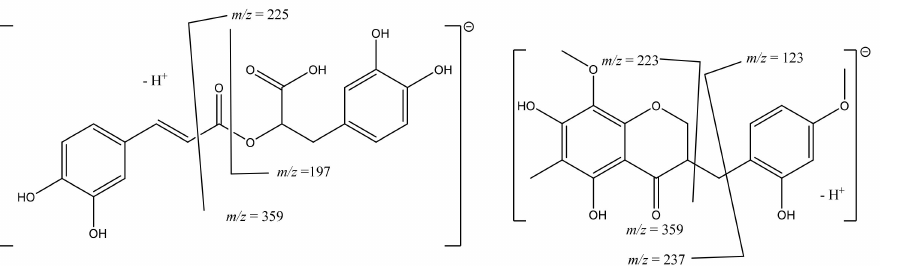
Figure 3. Rosmarinic acid and ophiopogonanone E main